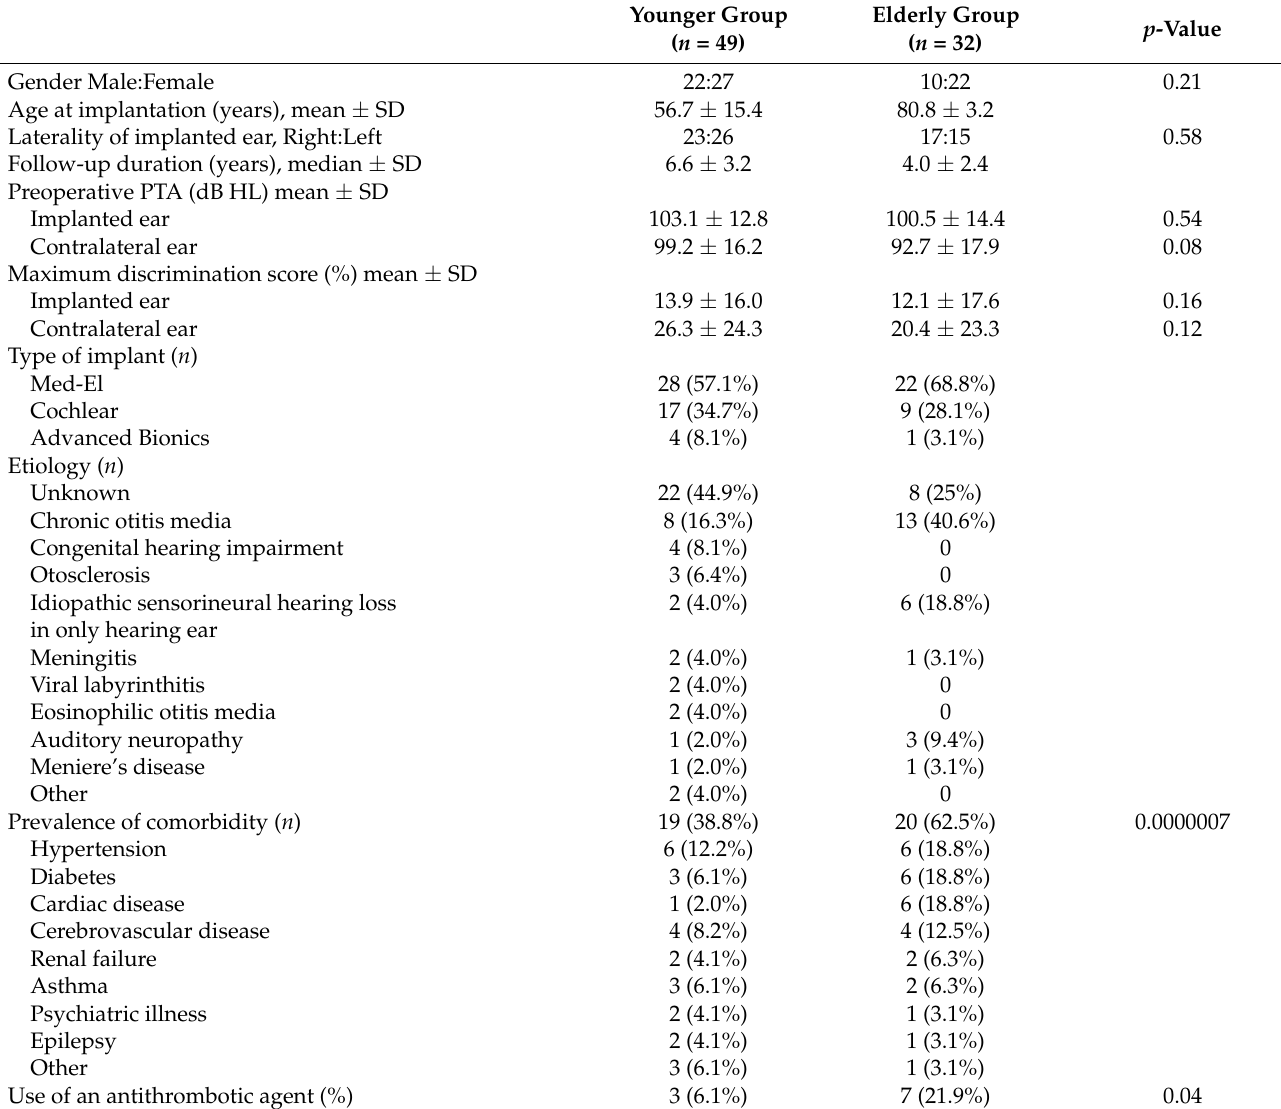
Table 1. Patient demographic and clinical